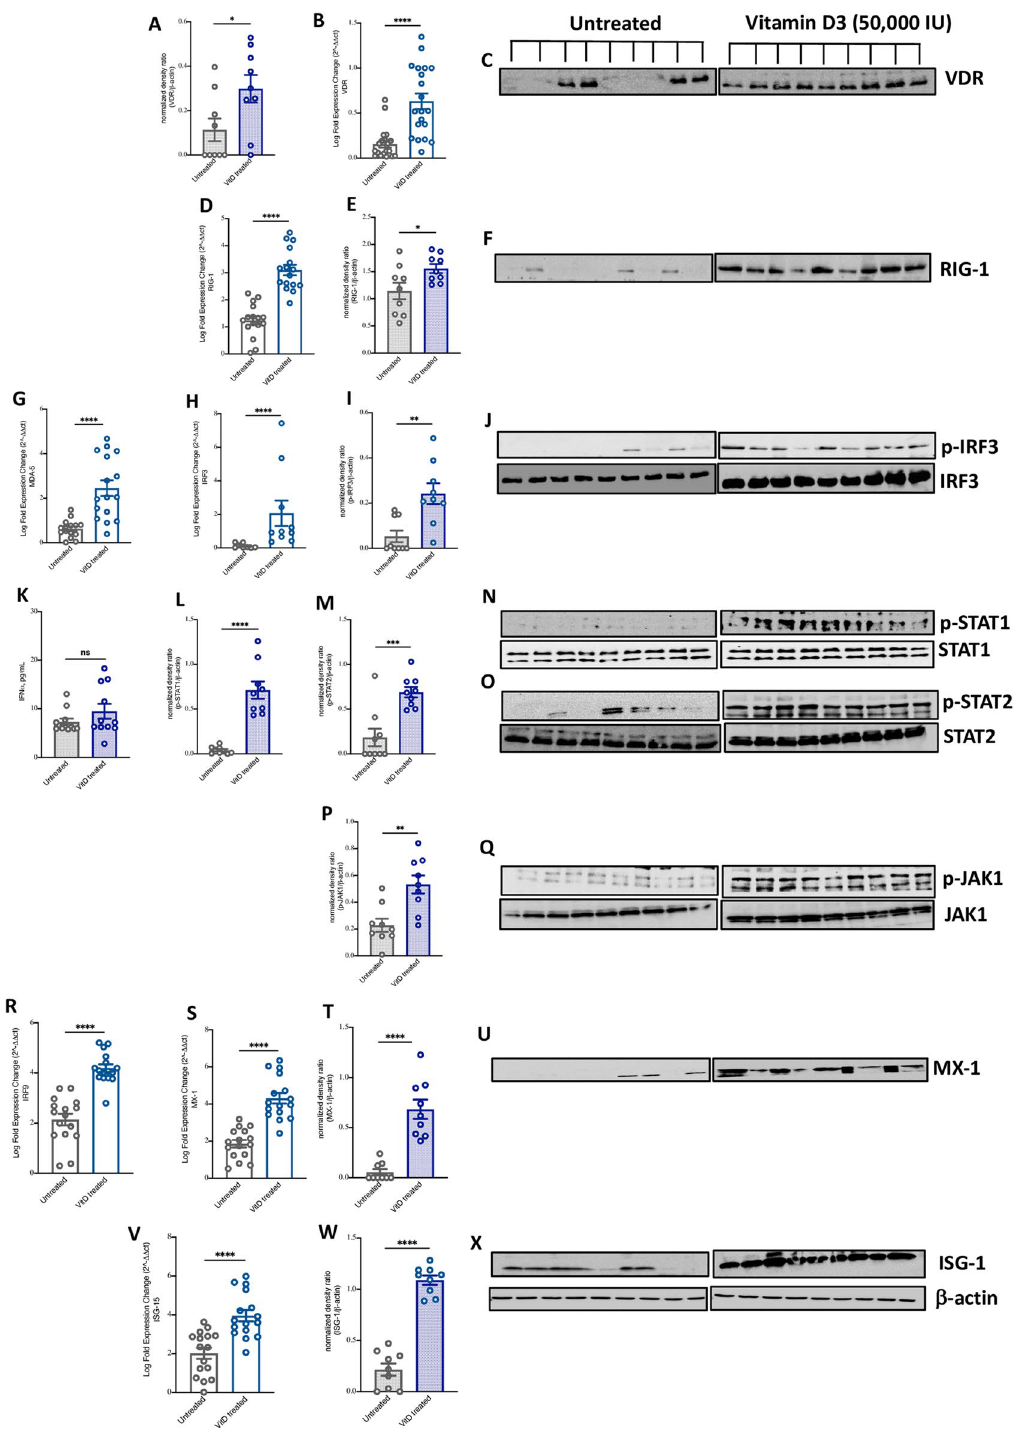
Figure 2. Increased IFNα/β signaling in blood of VitD treated COVID-19 patients. ( A – C ) The mRNA and protein levels of VDR in whole blood of VitD treated (cholecalciferol was administrated as 50,000 IU weekly) and untreated COVID-19 patients. ( D – J ) The mRNA and/or protein levels of RNA cytosolic sensing proteins, such as RIG-1, MDA5, and p-IRF3 in whole blood of VitD treated and untreated COVID-19 patients. ( K ) The plasma levels of IFN α in VitD treated and VitD untreated COVID-19 patients. ( L – Q ) Protein levels of p-STAT1, p-STAT2, and p-JAK1 in blood of VitD treated and VitD untreated COVID-19 patients. ( R – X ) The mRNA and/or protein levels of IRF3 and ISGs such as MX-1 and ISG-15 in blood of VitD treated and VitD untreated COVID-19 patients. The whole blood of VitD treated (n = 9; 6 males and 3 females) and untreated COVID-19 patients (n = 9; 6 males and 3 females) were randomly chosen from cohorts of VitD treated (n = 43; 36 males and 7 females) or untreated (n = 37; 27 males and 10 females) COVID-19 patients. Statistic test: comparison was done using unpaired t-test or Mann–Whitney U test, depending on the skewness of the data. *P < 0.05, **P <